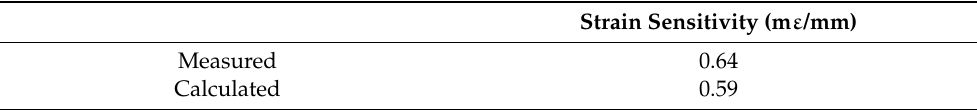
Table 3. Comparison between measured and calculated strain sensitivity of the replaceable measuring